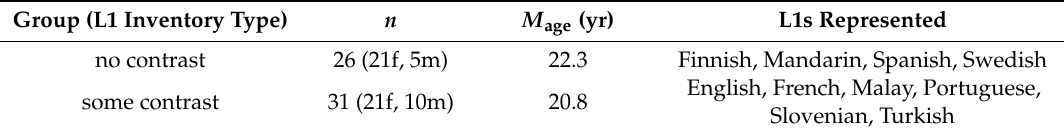
Table 4. Background information on participant groups in the vowel study.